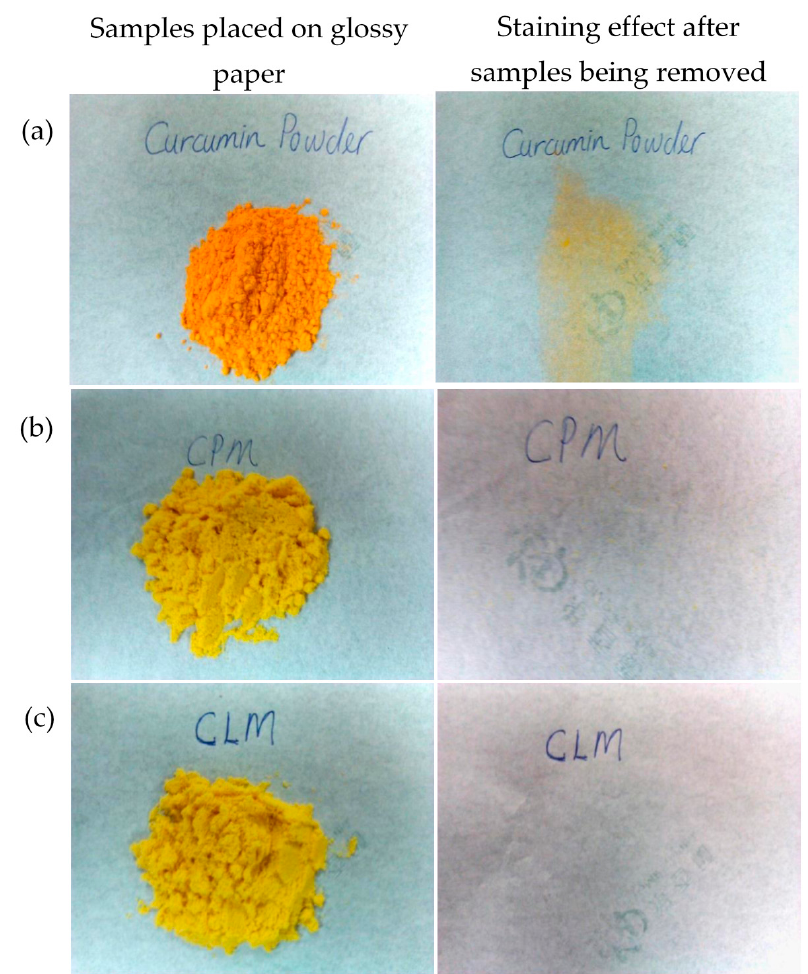
Figure 3. Pictures show the physical appearance and the staining effect of: ( a ) native curcuminoids powder, ( b ) cross-linked CPM and ( c ) non-cross-linked CPM. * CLM: non-crossed-linked.